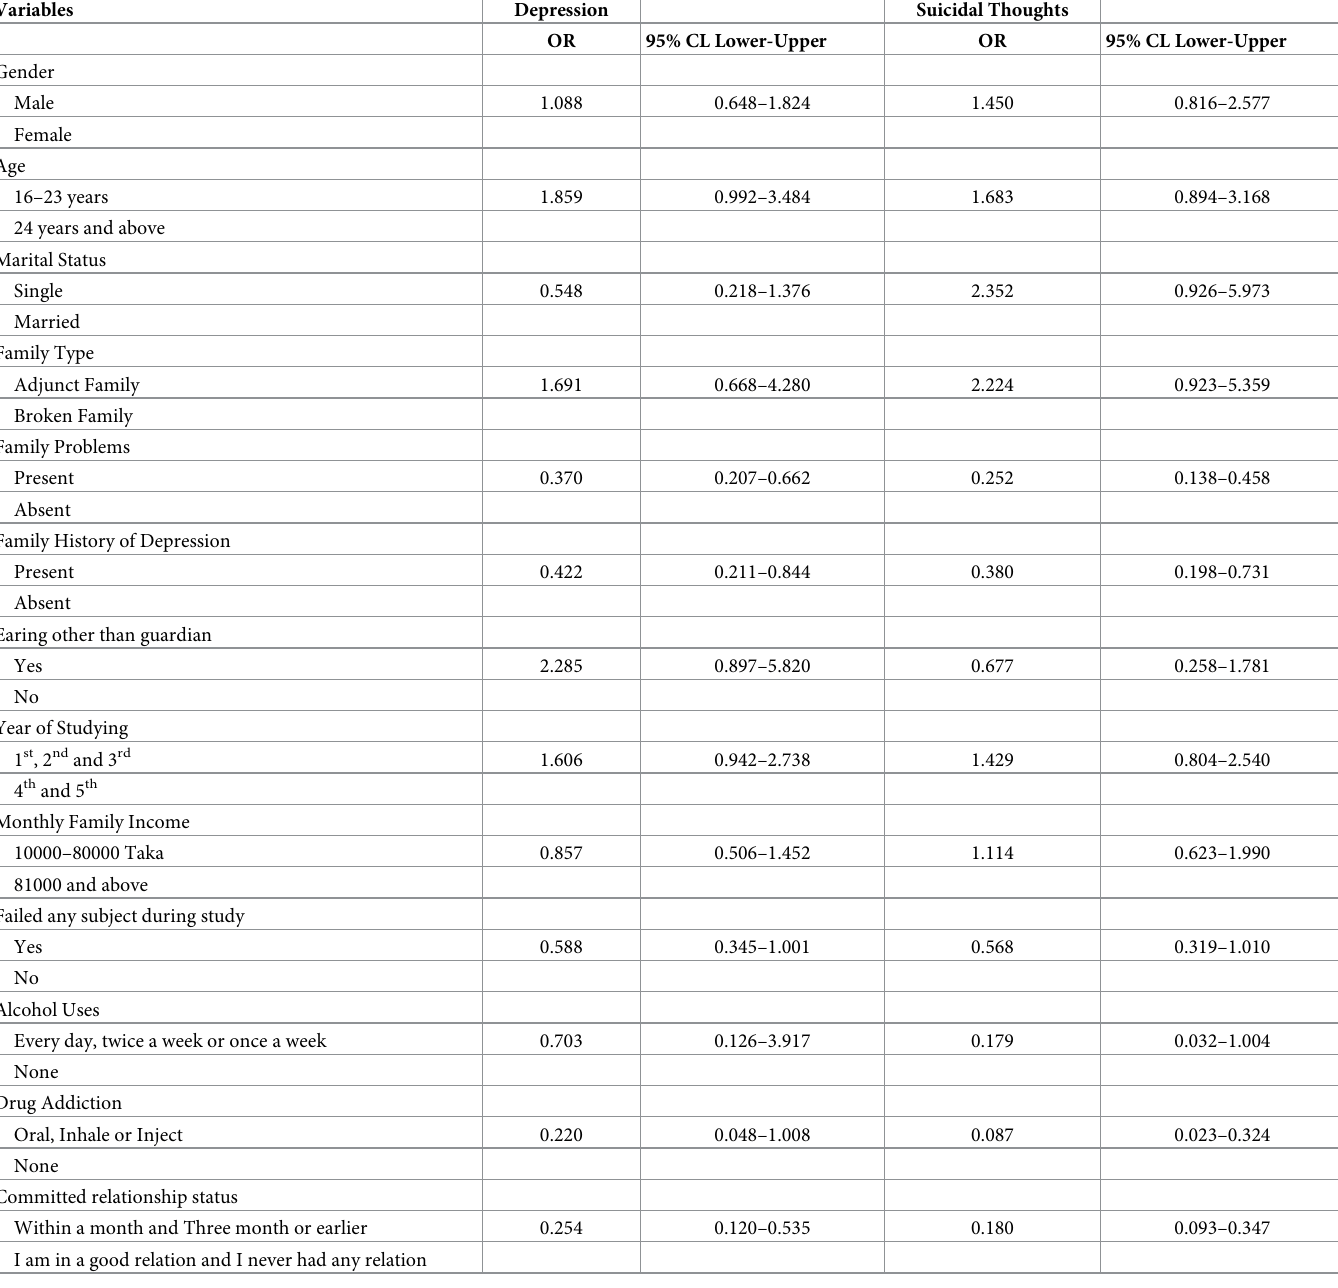
Table 3. Odd Ratio and 95% Confidence Interval of different variables among medical students of Enam Medical College & Hospital, Savar, Dhaka, Bangladesh, 2020 (n =